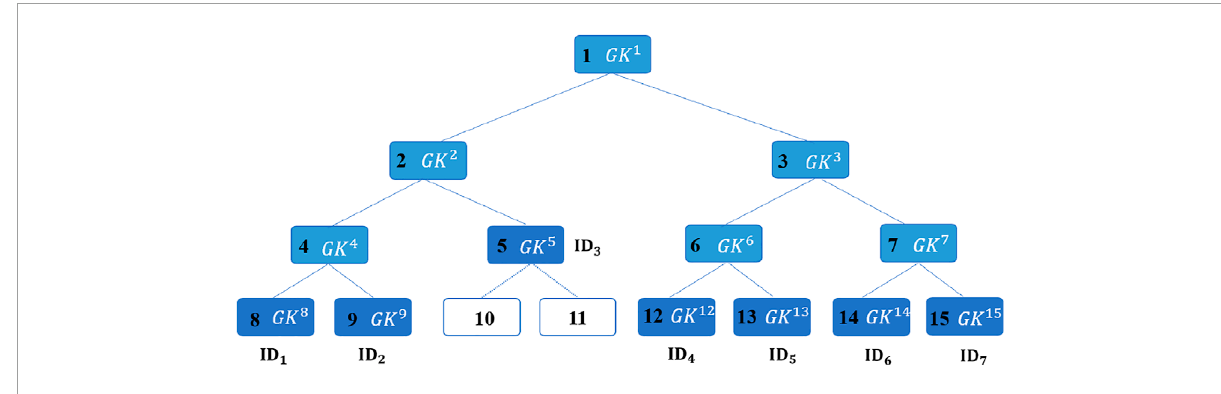
FIGURE 3 An example of OFT key tree.